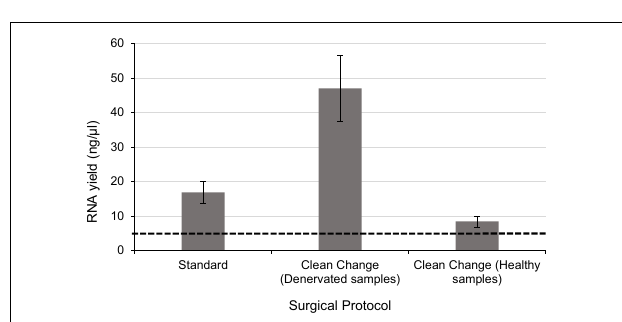
FIGURE 4 | RNA yield from rodent nerves is reduced following exposure to surgical antiseptic reagents There was a statistically significant difference between the untreated ( n = 8) and each of the treated groups (2% Chlorhexidine gluconate ( n = 6), 10% lodine/EtOH ( n = 6). 10% lodine/H2O < n = 6) as assessed by a one way ANOVA and Dunnett’s test ( p < 0.0l between each treatment group and the untreated group). Data are means ± 1 SD. The black dotted line at 5 ng/ul represents the minimum concentration of RNA required for downstream RT-qPCR and RNA seq